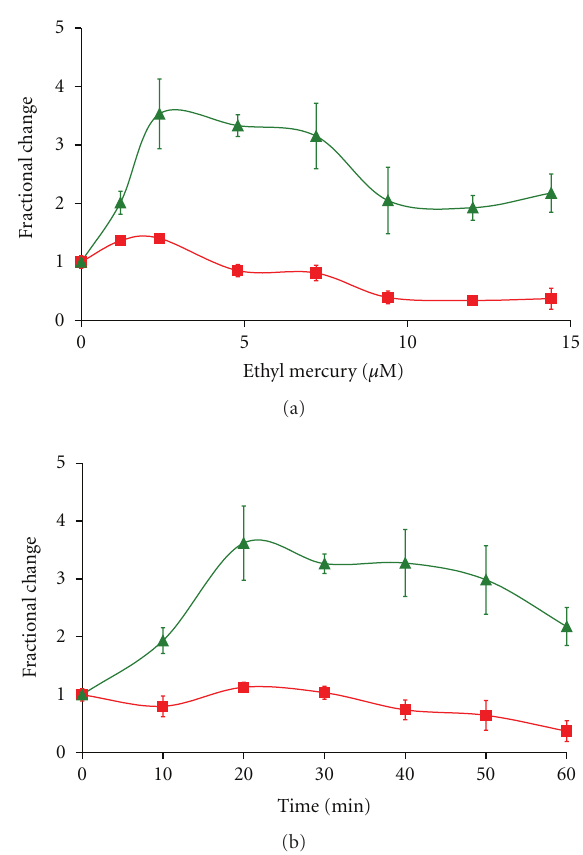
Figure 1: Changes in mitochondrial membrane potential and of ROS generation induced by ethylmercury in Normal Human Astrocytes. Changes in mitotracker and ROS induced DCF levels caused by incubation with increasing concentrations of Thimerosal (b) and the time course of incubation with 14.4 µ M Thimerosal (a), with respect to control cultures. Cells were imaged in the centerfield of three independent wells, consisting of an average of 44 cells per field, with a standard deviation of